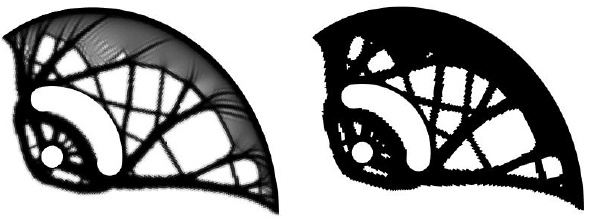
Figure 8. The first optimization run–density distribution field in grey-scale: black color—keep element, white color—remove element ( left ) and pseudo-density distribution field using the density limit value x lim = 0.1 ( right ).